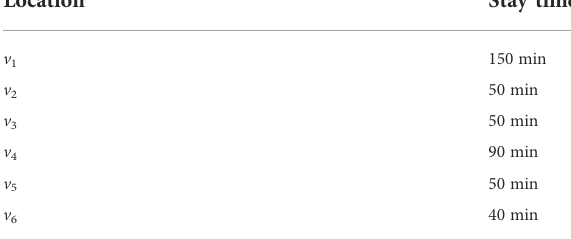
TABLE 4 Time spent at each